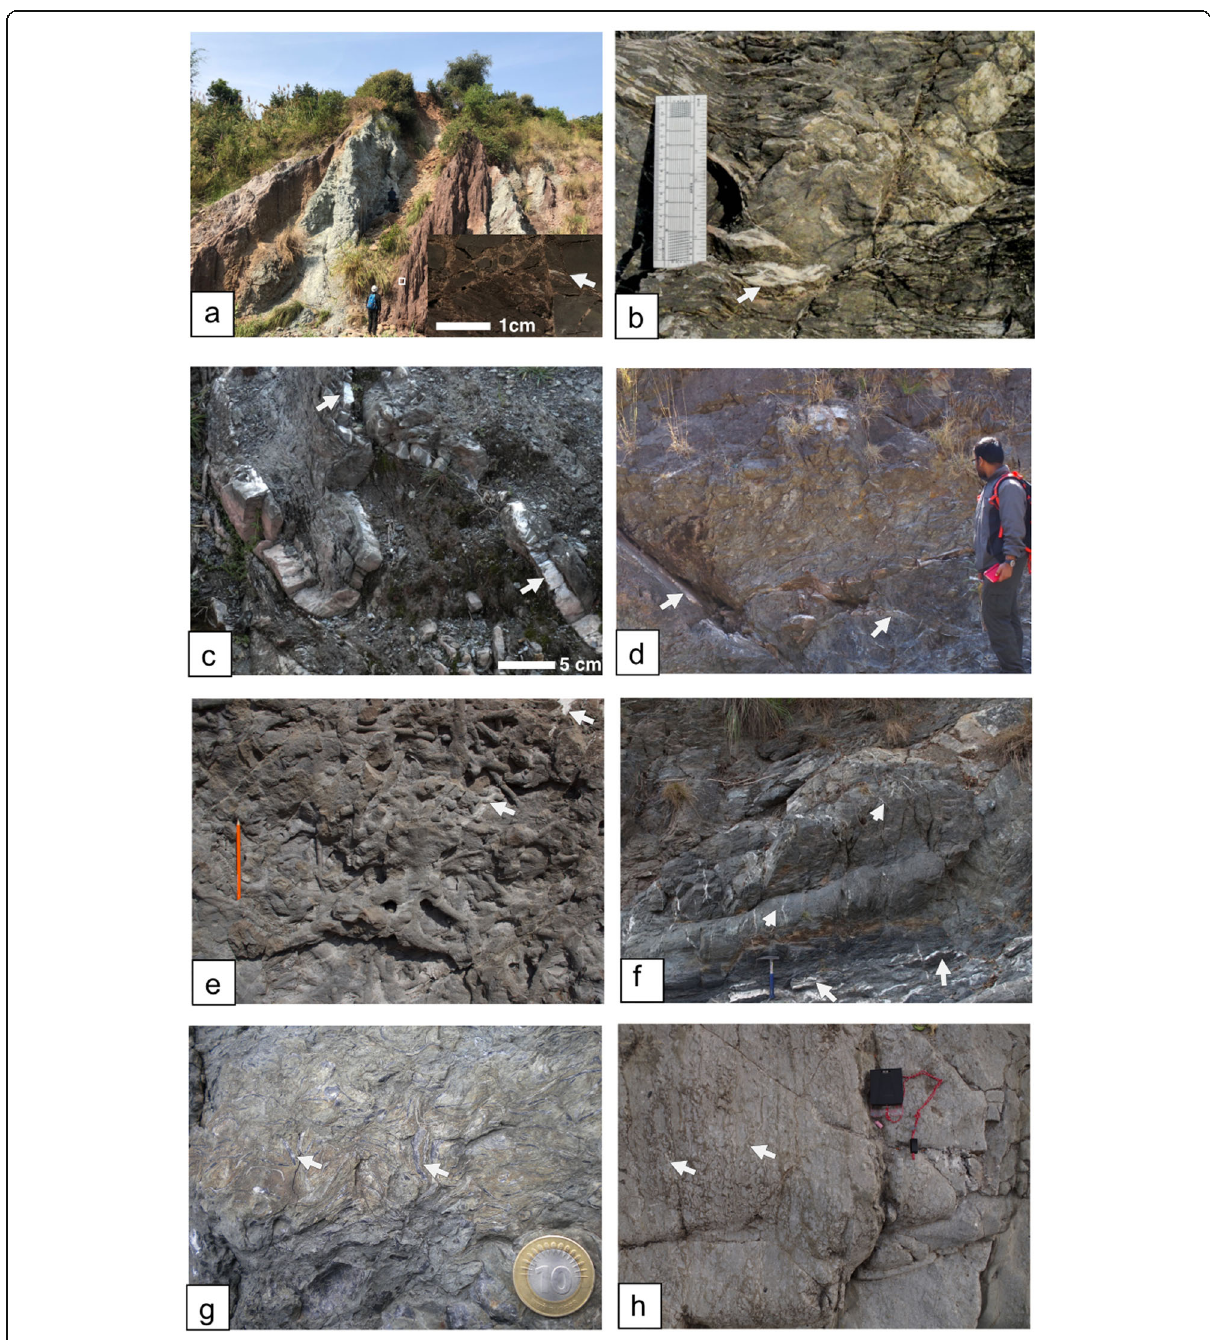
Fig. 2 a The gouge rocks of NT exhibiting fragmented calcite veins (PJ5). The inset shows fragments of calcite vein (arrow) in obtained sample. b Folded calcite veins (arrow) (PWN1) occurring in the hanging wall of BT. c Co-folded calcite veins (CM2) occurring near a splay thrust of RT. d Folded calcite veins (KP1) occurring near deformed rocks of RT. e Calcite veins (arrows) within fossiliferous limestones of Subathu Formation in footwall of MBT. f Folded and deformed calcite veins (long arrows) (GM8) within the calcareous shale and limestone alternation of Subathu Formation occurring in footwall of MBT. The narrow dilational veins (short arrow) (GM8a) are of older generation. g Fossiliferous limestone of Subathu formation (CM1) showing well preserved fossils (arrows). h Stromatolitic limestone (GM5I) (arrows show lining of stromatolite layers) of Krol Formation, occurs as discrete bodies within the hanging wall of